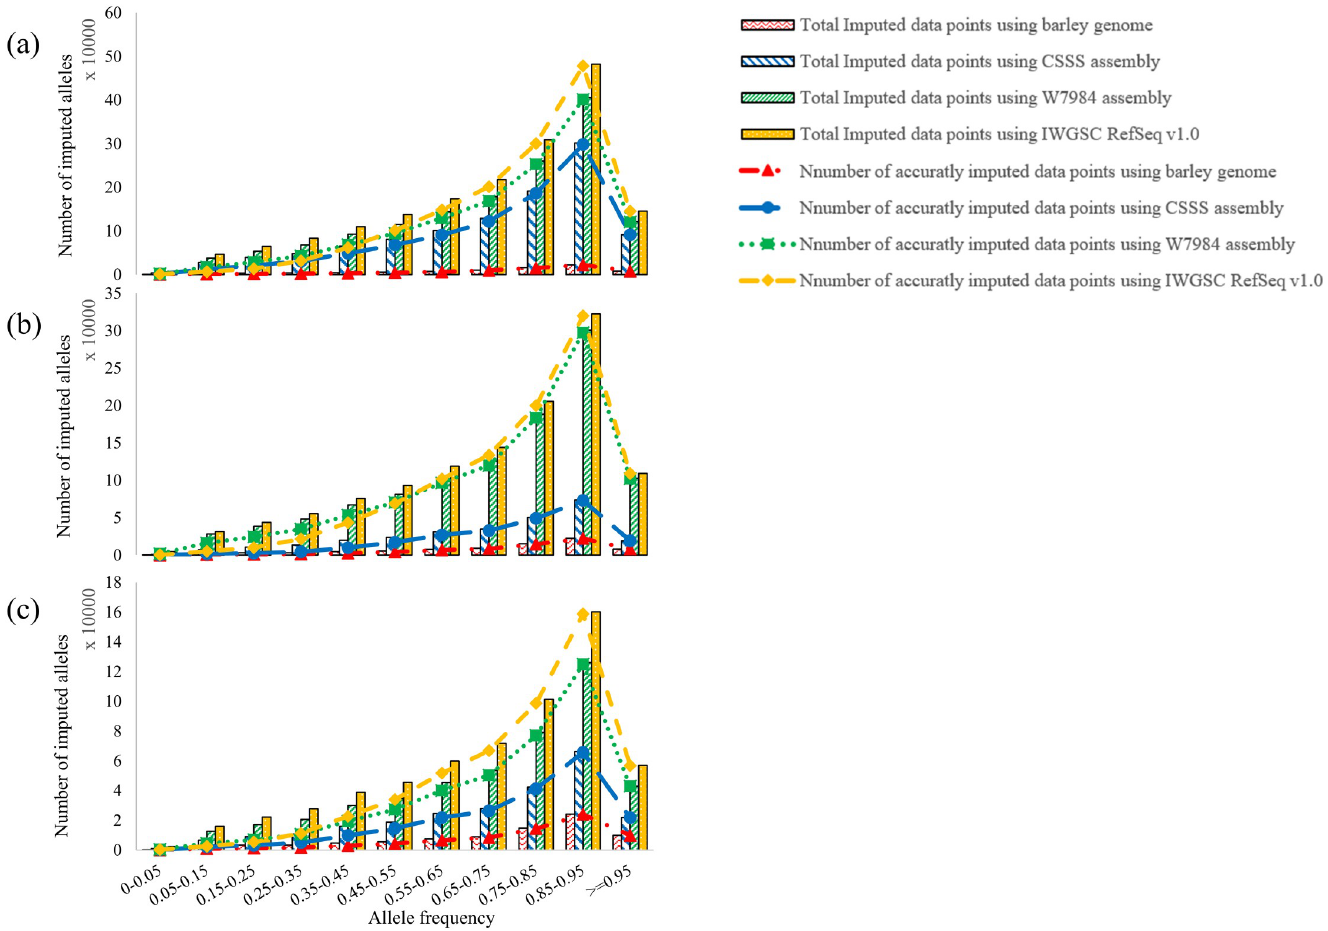
Fig 4. Number of total and correctly imputed alleles for different allele frequencies for (a) five, (b) six, (c) seven runs imputed with eight runs using barley genome, Chinese Spring survey sequence (CSSS), W7984 and IWGSC RefSeq 1.0 in Iranian wheat GBS data.